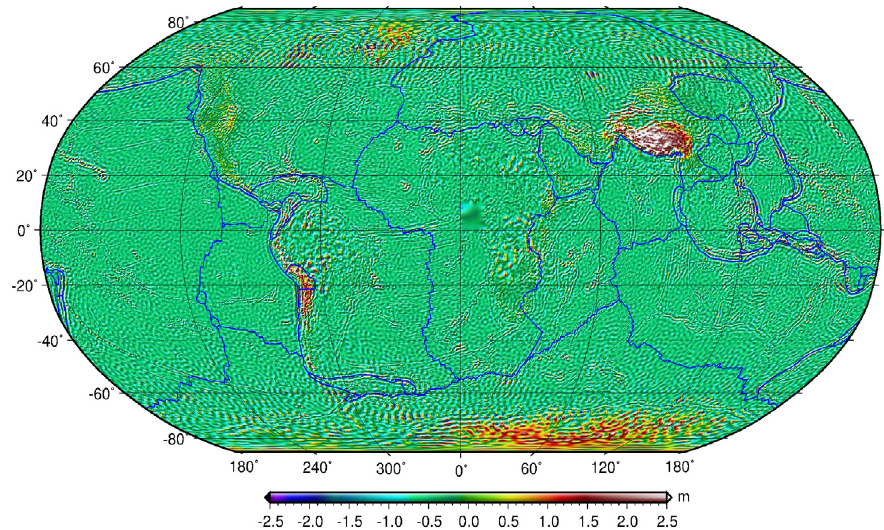
Figure 1. Differences of geoids [m] between the EGM2008 up to 2190 degree/order and the NULP-02S up to 250 degrees/order models ( ––– basic plates boundaries).